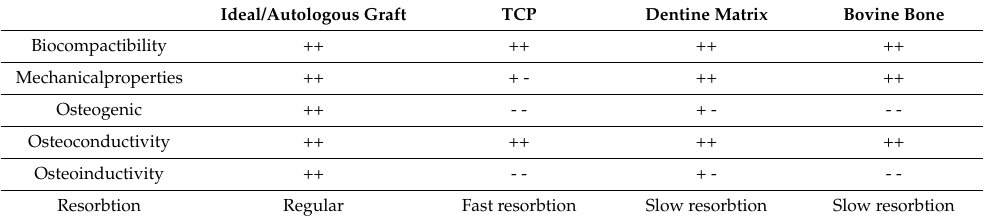
Table 5. Comparative summary of the main biomaterials’